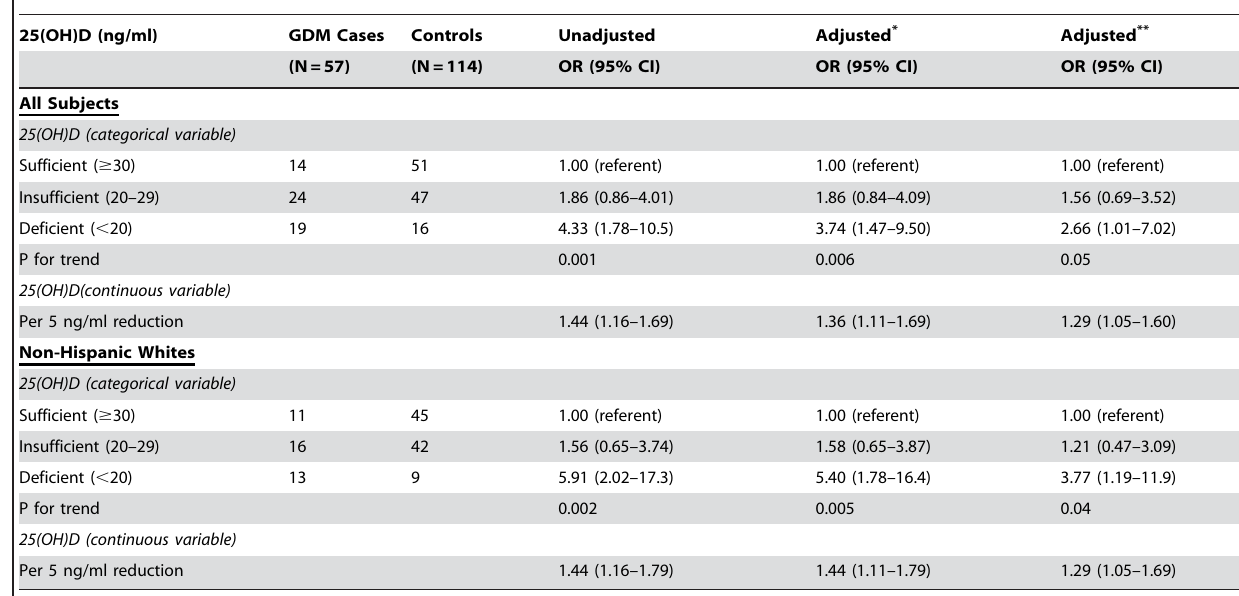
Table 2. Odds ratios (OR) and 95% confidence intervals (CI) for gestational diabetes (GDM) according to maternal plasma 25- hydroxyvitamin D (25(OH)D) concentrations in pregnancy.